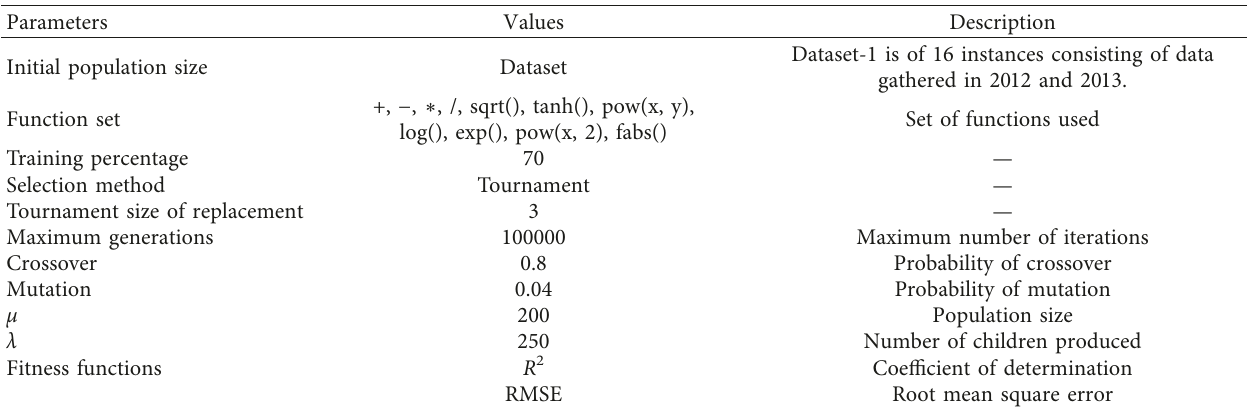
Figure 13: Progressive variation of IRI for the road sections UR01 to UR16. Table 4: Architecture of the GP